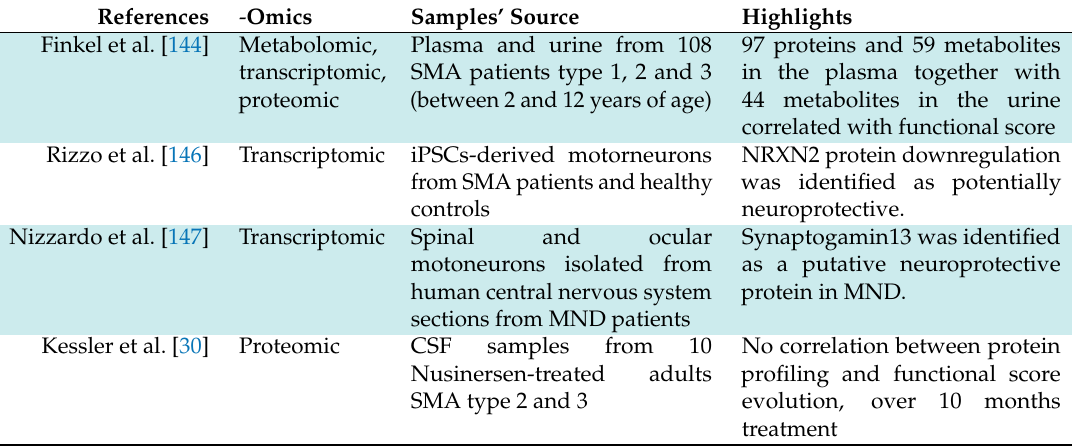
Table 5. Overview of multi-omics approaches used to date to characterize SMA and its progression. References: bibliographic citations of the -omics studies. -Omics: Specific techniques employed in each study. Samples’ source: biological material analyzed. Highlights: main insights on SMA pathogenesis gained in each study. Background colors are used to differentiate the cited